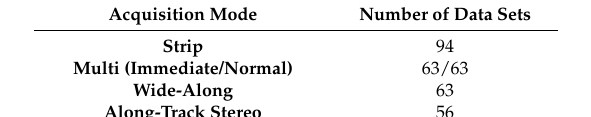
Table 5. Test data used for the positional accuracy validation.